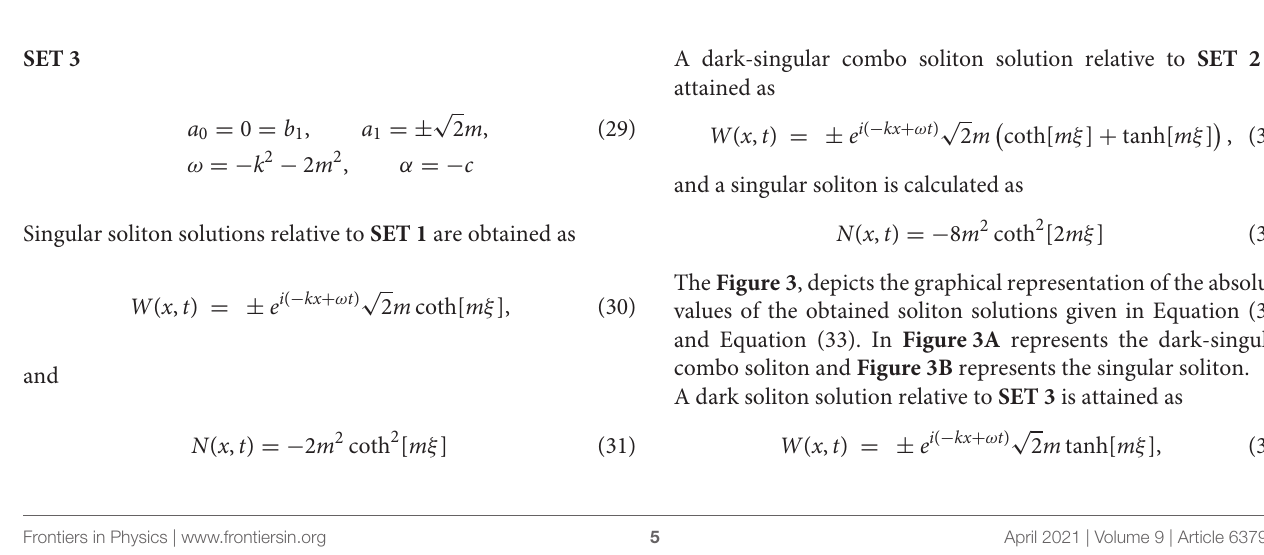
1, d 1, k 1 and ξ = = =